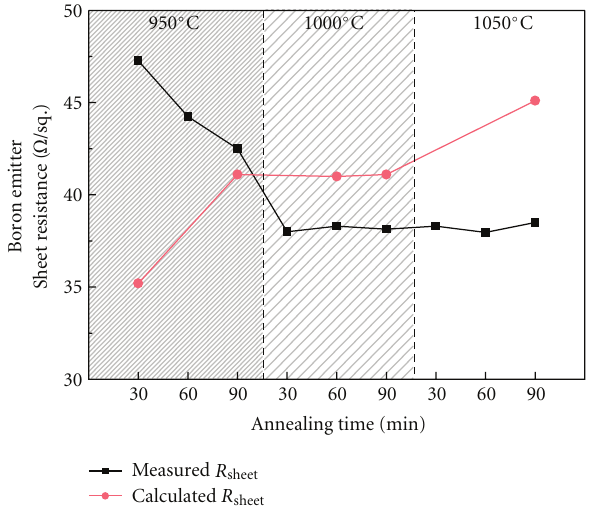
Figure 4: Measured and calculated sheet resistance of phosphorus- implanted samples with di ff erent annealing conditions.